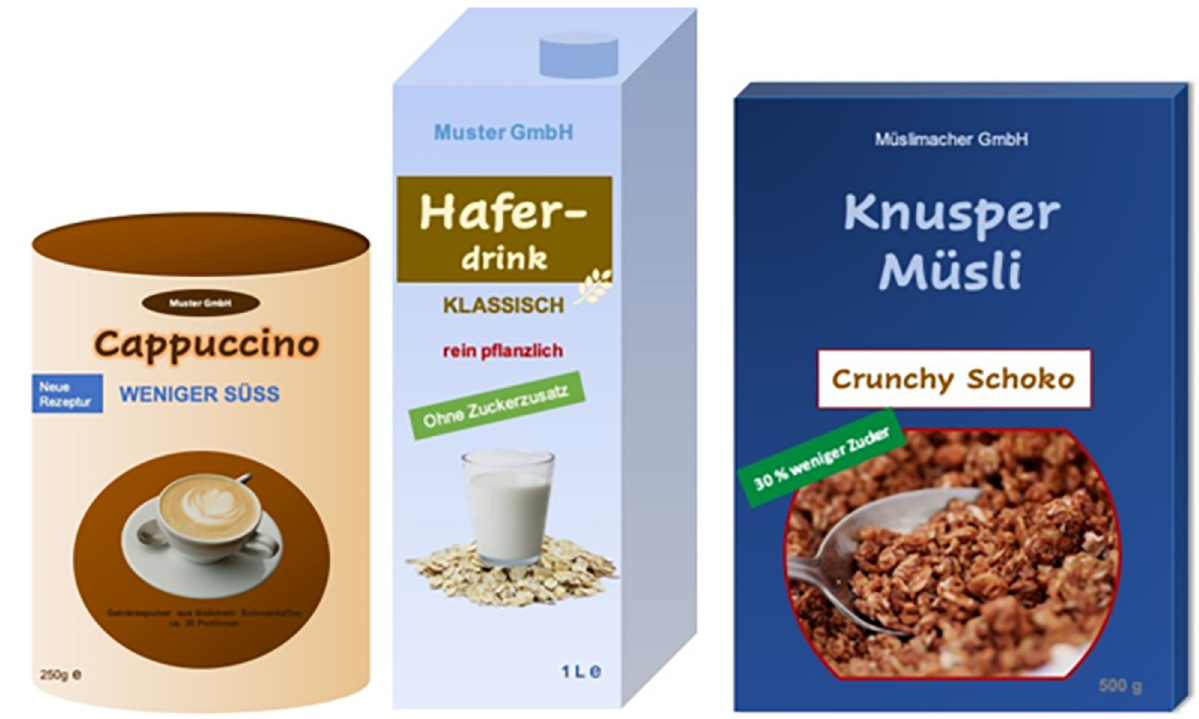
Fig 2. Product examples with the three claim variations: Instant cappuccino (less sweet), oat drink (without added sugar), chocolate crunchy muesli (30% less sugar).